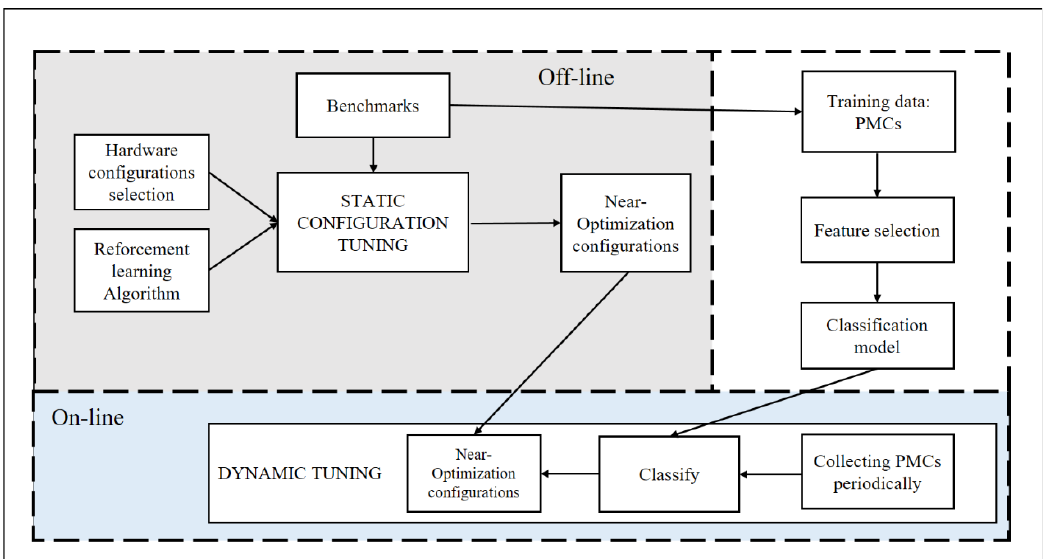
Figure 1. The dynamic tuning framework and workflow.